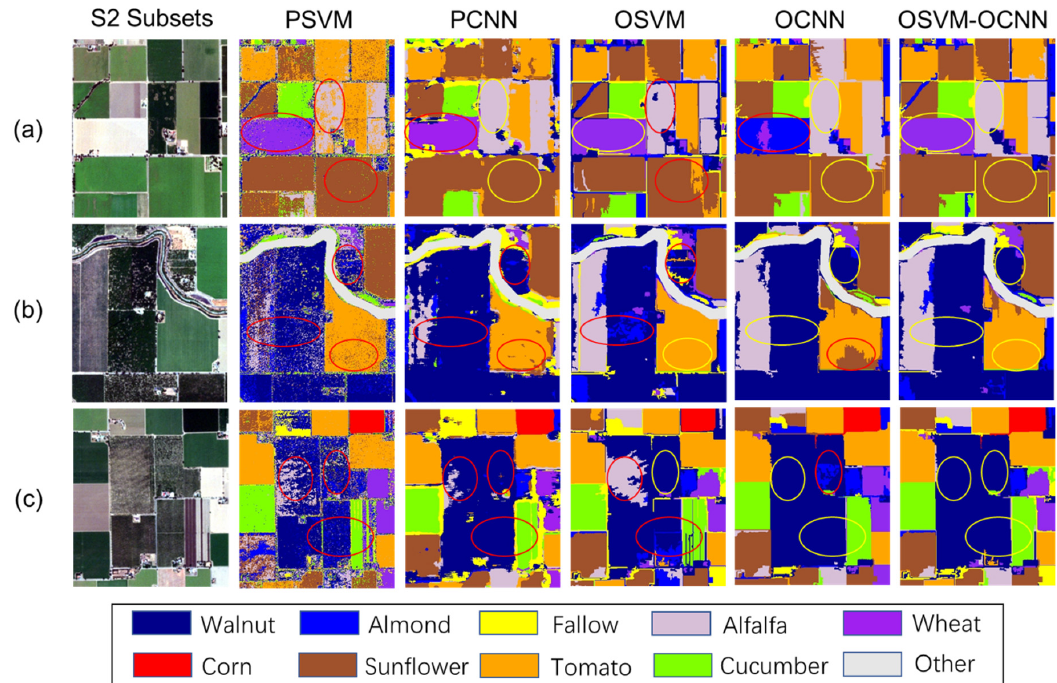
Figure 7. Three representative subsets ( a – c ) from the RapidEye imagery with the corresponding classification maps; the first column shows the RapidEye images (bands Red, Green and Blue), the following columns illustrate the classification maps achieved by the PSVM, PCNN, OSVM, OCNN and the proposed OSVM-OCNN, respectively; the regions with correct and incorrect classification results were labelled with yellow and red circles, respectively.